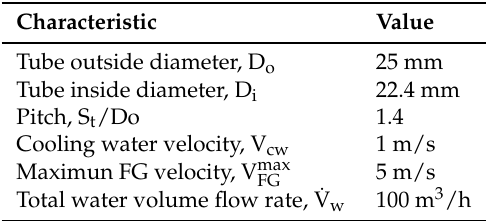
Table 2. The Flue Gas Condenser (FGC) design parameters considered in the representative DH plant case study. They are selected based on the different recommendations exposed in References